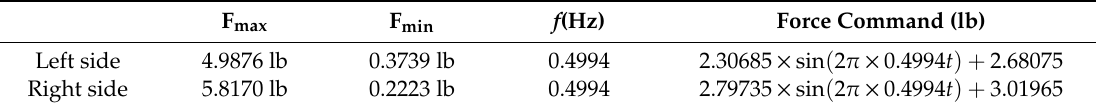
Table 4. Parameter settings for the motor control system.